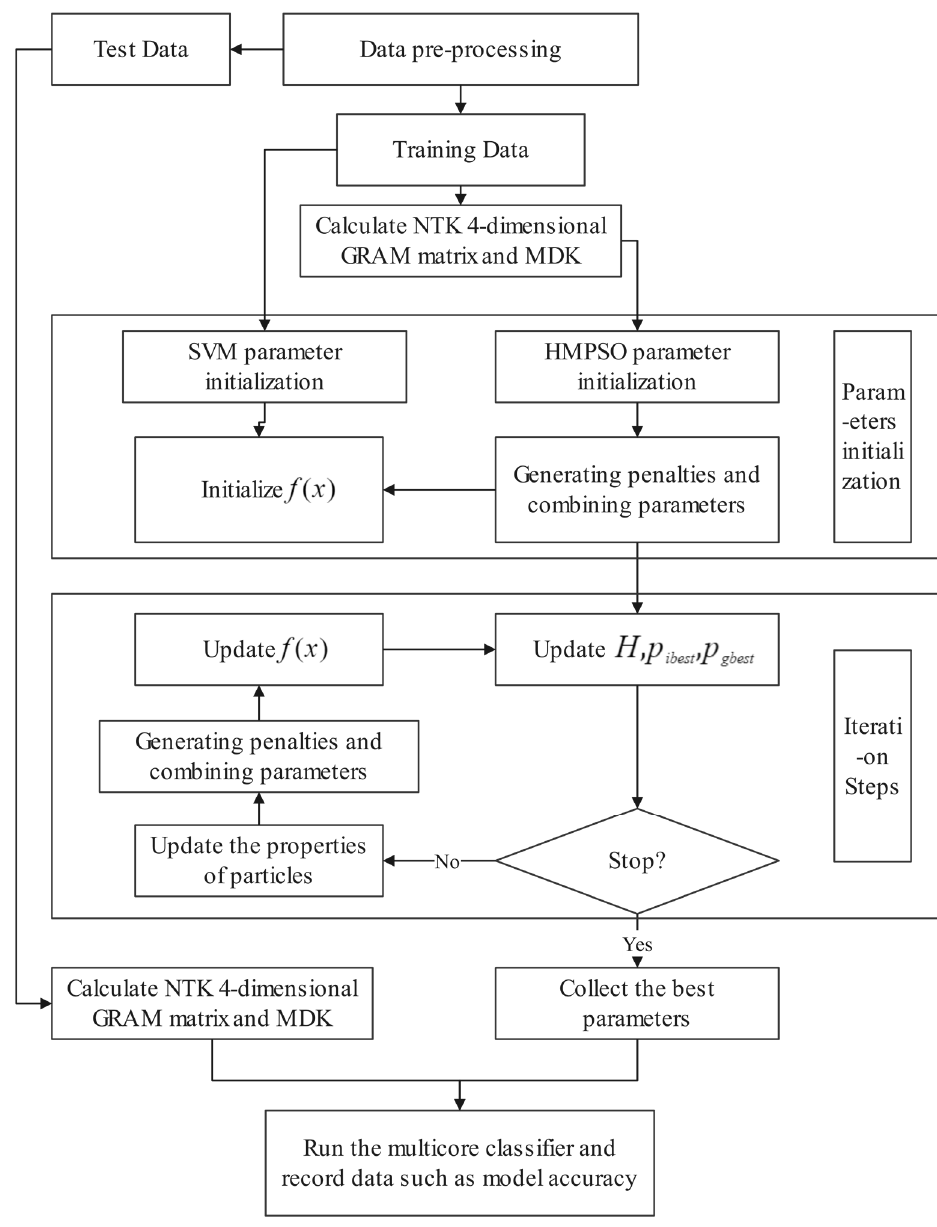
Figure 1. Flow chart of multi-kernel-NTK mode.